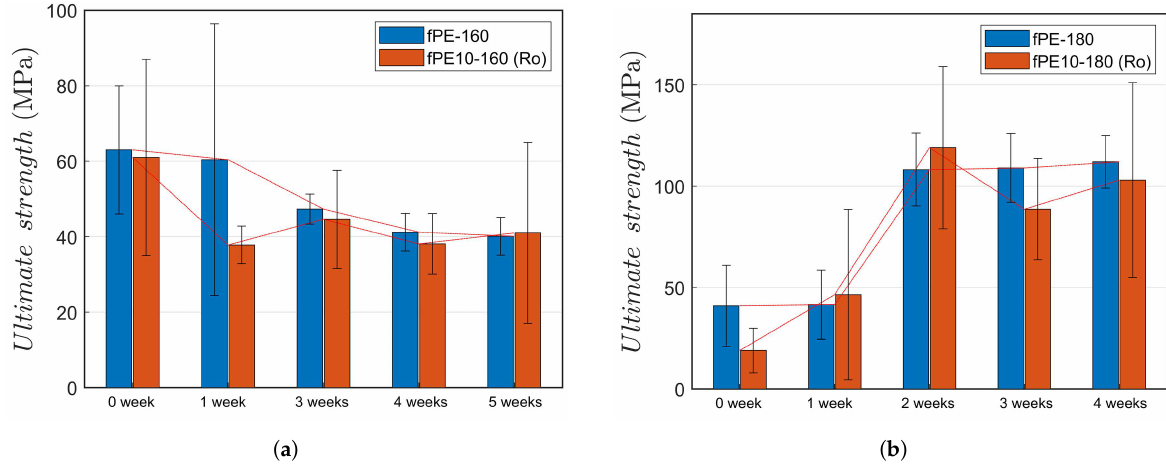
Figure 4. The effects of thermal ageing at 60 ℃ : ( a ) PE fibres (with melt-spinning temperature of 160 ℃ ) with and without rosin; ( b ) PE fibres (with melt-spinning temperature of 180 ℃ ) with and without rosin. The PLA series fibres lost their fibrous form and could not be tested.